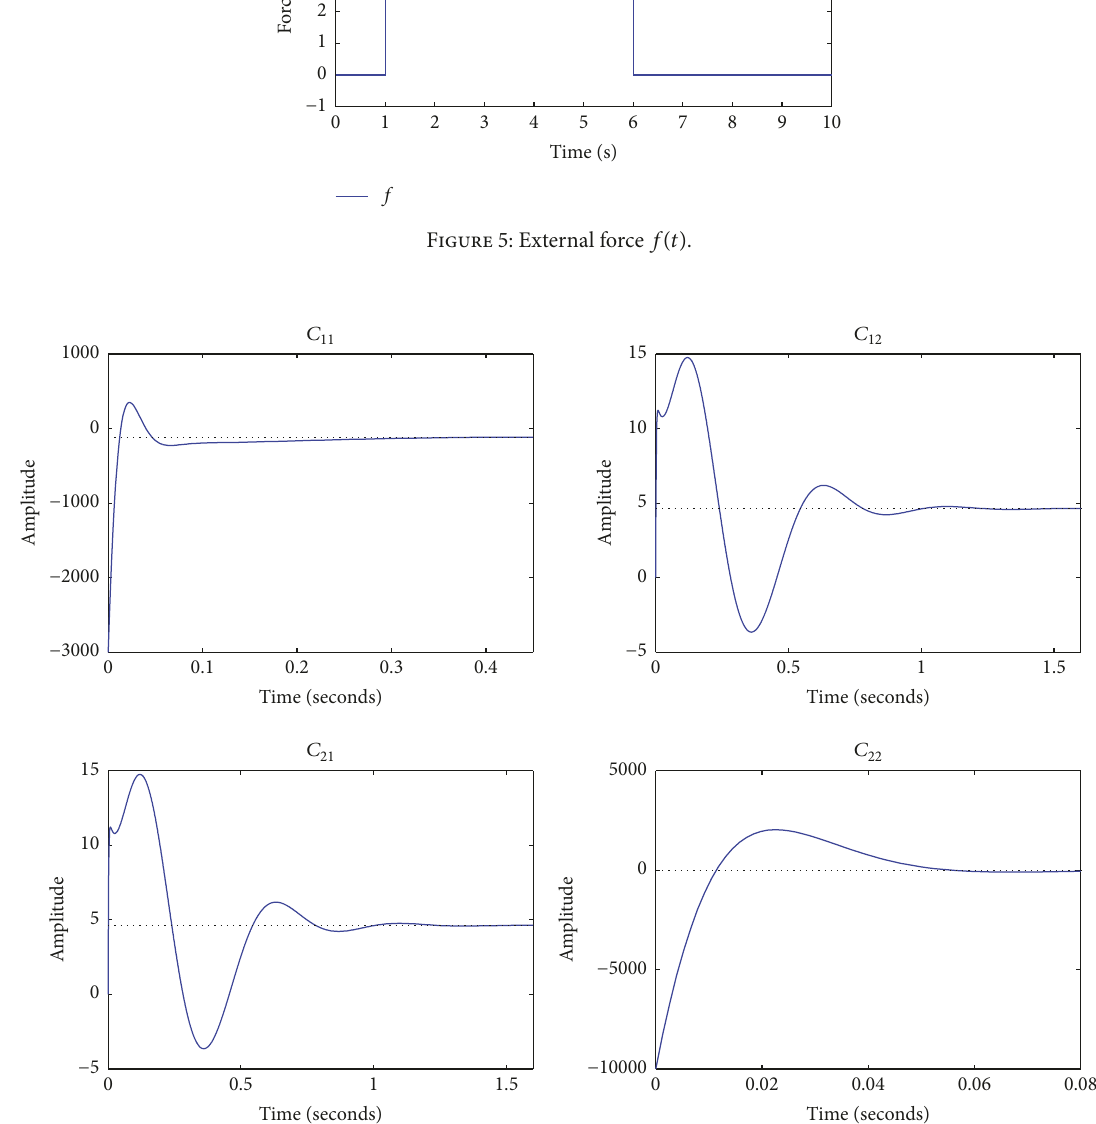
Figure 6: Step responses of 𝐶 11 (𝑠) , 𝐶 12 (𝑠) , 𝐶 21 (𝑠) , and 𝐶 22 (𝑠)